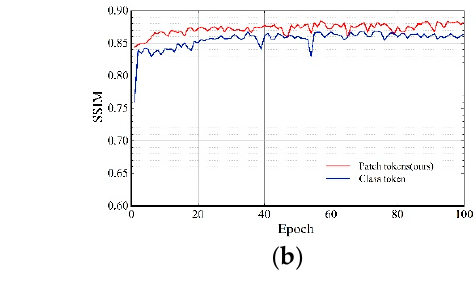
Figure 8. Effects of ablation study (3). Table 5. Average PSNR/SSIM of ablation study (3).